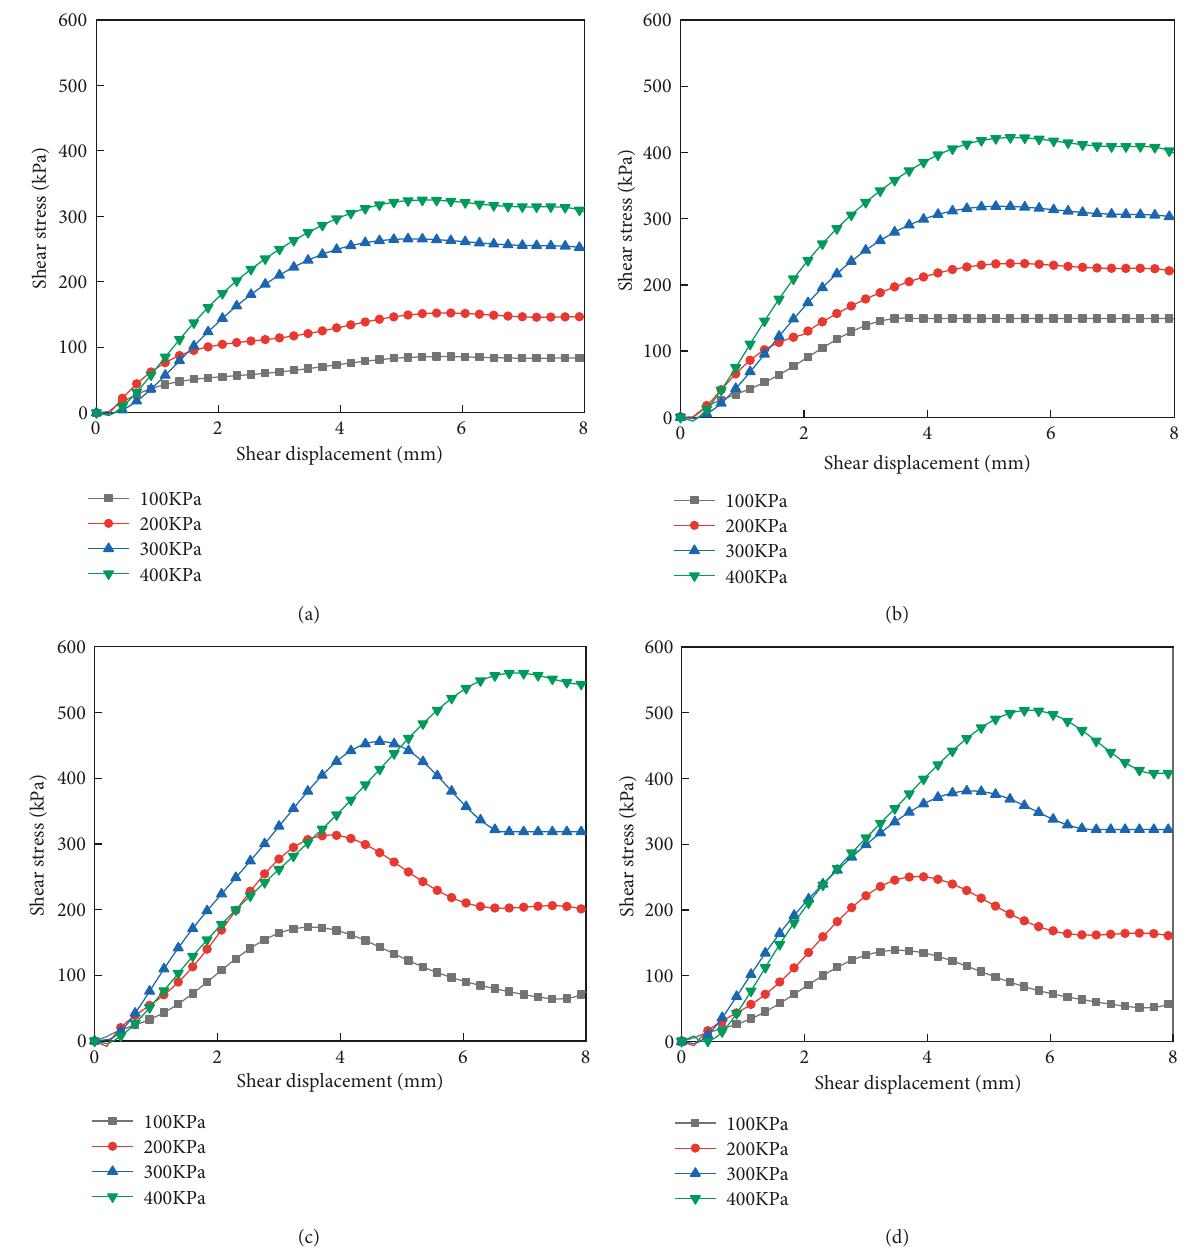
Figure 7: The shear stress-shear displacement curve for the lunar soil simulant. (a) Sodium silicate content is 0%. (b) Sodium silicate content is 3%. (c) Sodium silicate content is 5%. (d) Sodium silicate content is